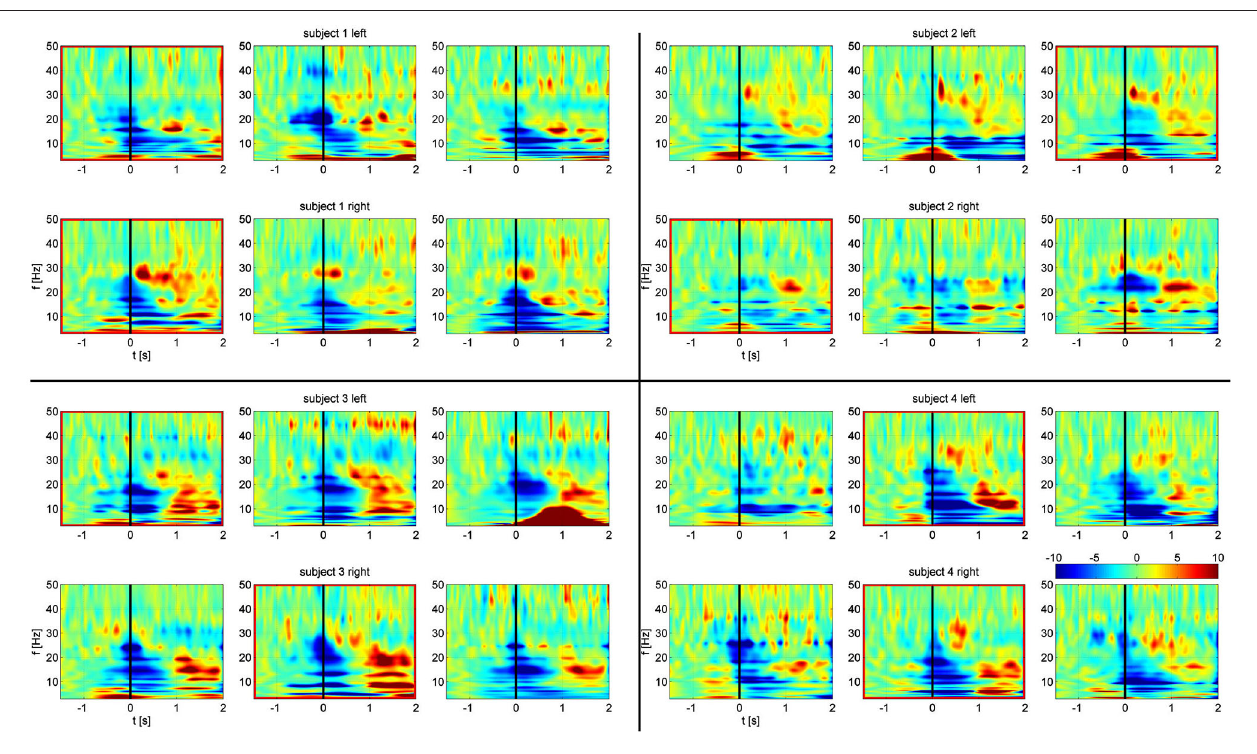
on a − 1.5 s to − 0.8 s baseline period. Channels outlined in red show significant task related alpha frequency phase synchronization. Movement onset defined by EMG is at time zero, indicated by the black